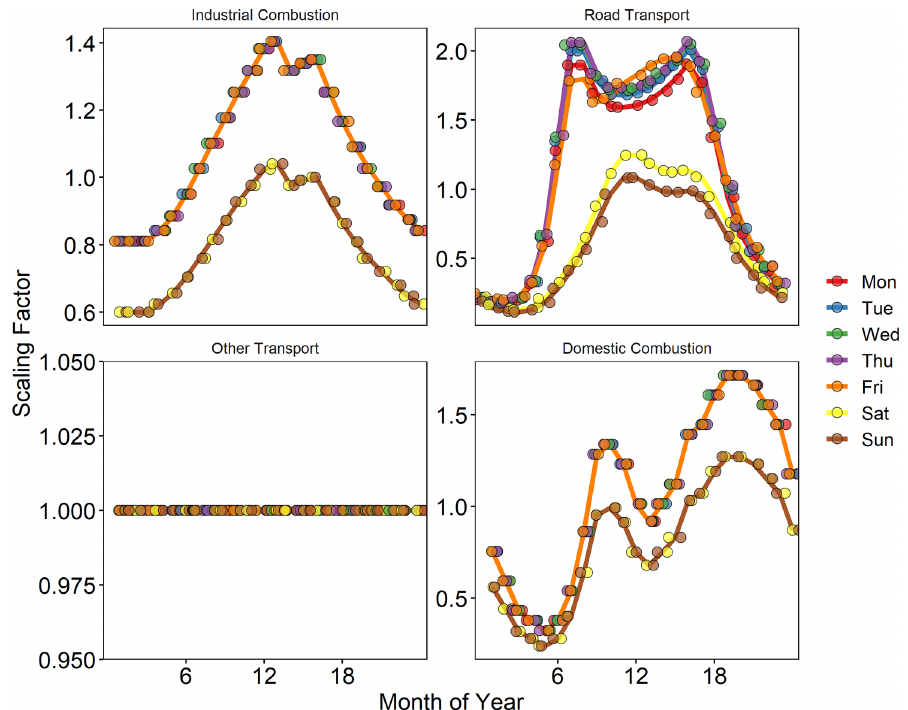
Figure A3. Hour of day scaling factors for the four SNAP sectors (07, 02, 03, and 08, see Table A1) contributing to the majority of NO x emissions around the BT Tower, coloured by day of week. Overlapping points for identical profiles have been offset in the x direction to improve